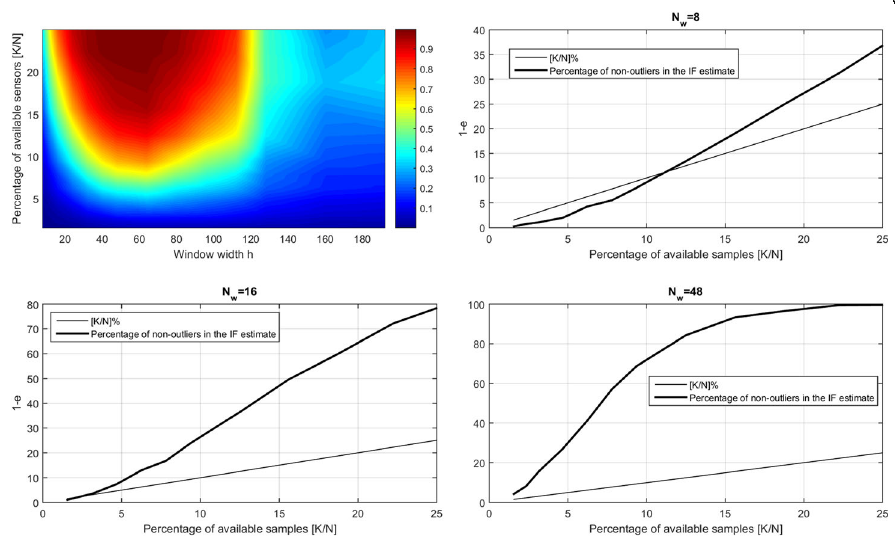
Fig. 1 Colormap depicting the percentage of non-outliers in the IF estimate as a function of ratio K / N and window width h . Comparison of the percentage of non-outliers in the IF estimate with ratio K / N for three window lengths is given in the remaining